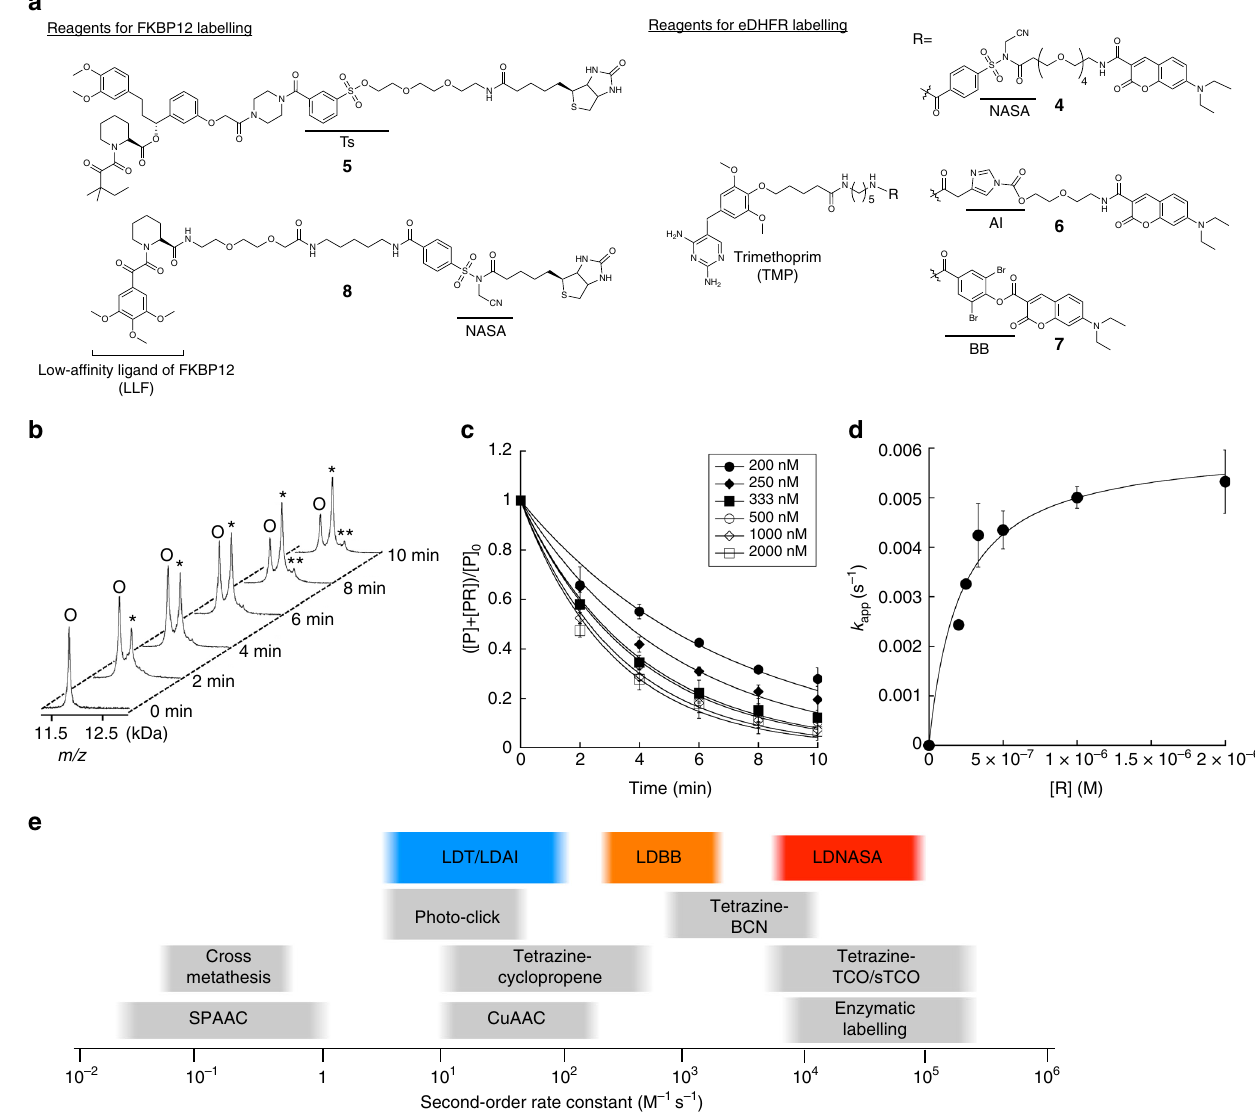
Fig. 3 Kinetic analysis of protein labelling with various LD reagents. a Molecular structures of LD reagents. NASA, N -acyl- N -alkyl sulfonamide; Ts, tosyl; AI, alkyloxyacyl imidazole; BB, dibromophenyl benzoate. b MALDI-TOF MS analyses of labelling process of FKBP12 with 1 . Puri fi ed FKBP12 (100 nM) was incubated with 1 (200 nM) in HEPES buffer (50mM, pH 7.2) at 37°C. O, native FKBP12 ( M w : 11 914); *, single-labelled FKBP12 ( M w : 12 140); **, double- labelled FKBP12 ( M w : 12 366). c Time course of the depletion of native (non-labelled) FKBP12 during the labelling reaction with various concentrations of 1 . Puri fi ed FKBP12 (100 nM) was incubated with reagents (200 – 2000 nM) in HEPES buffer (50mM, pH 7.2) at 37°C. The reaction was monitored by MALDI- TOF MS. The pseudo- fi rst order reaction rates ( k app ) were obtained by fi tting the data to Eq. (2). d The dependence of k app upon the concentration of 1 . Kinetic parameters were obtained by fi tting this data to Eq. (3). e Second-order rate constants of representative bioorthogonal reactions and LD chemistries for protein modi fi cation. Here, the rate constants for LD chemistries indicate the range of values when the af fi nity ( K d ) of the ligand is 10 − 7 – 10 − 6 M. The rate constants for the bioorthogonal reactions were obtained from refs 5,10 . Error bars represent s.d., n =